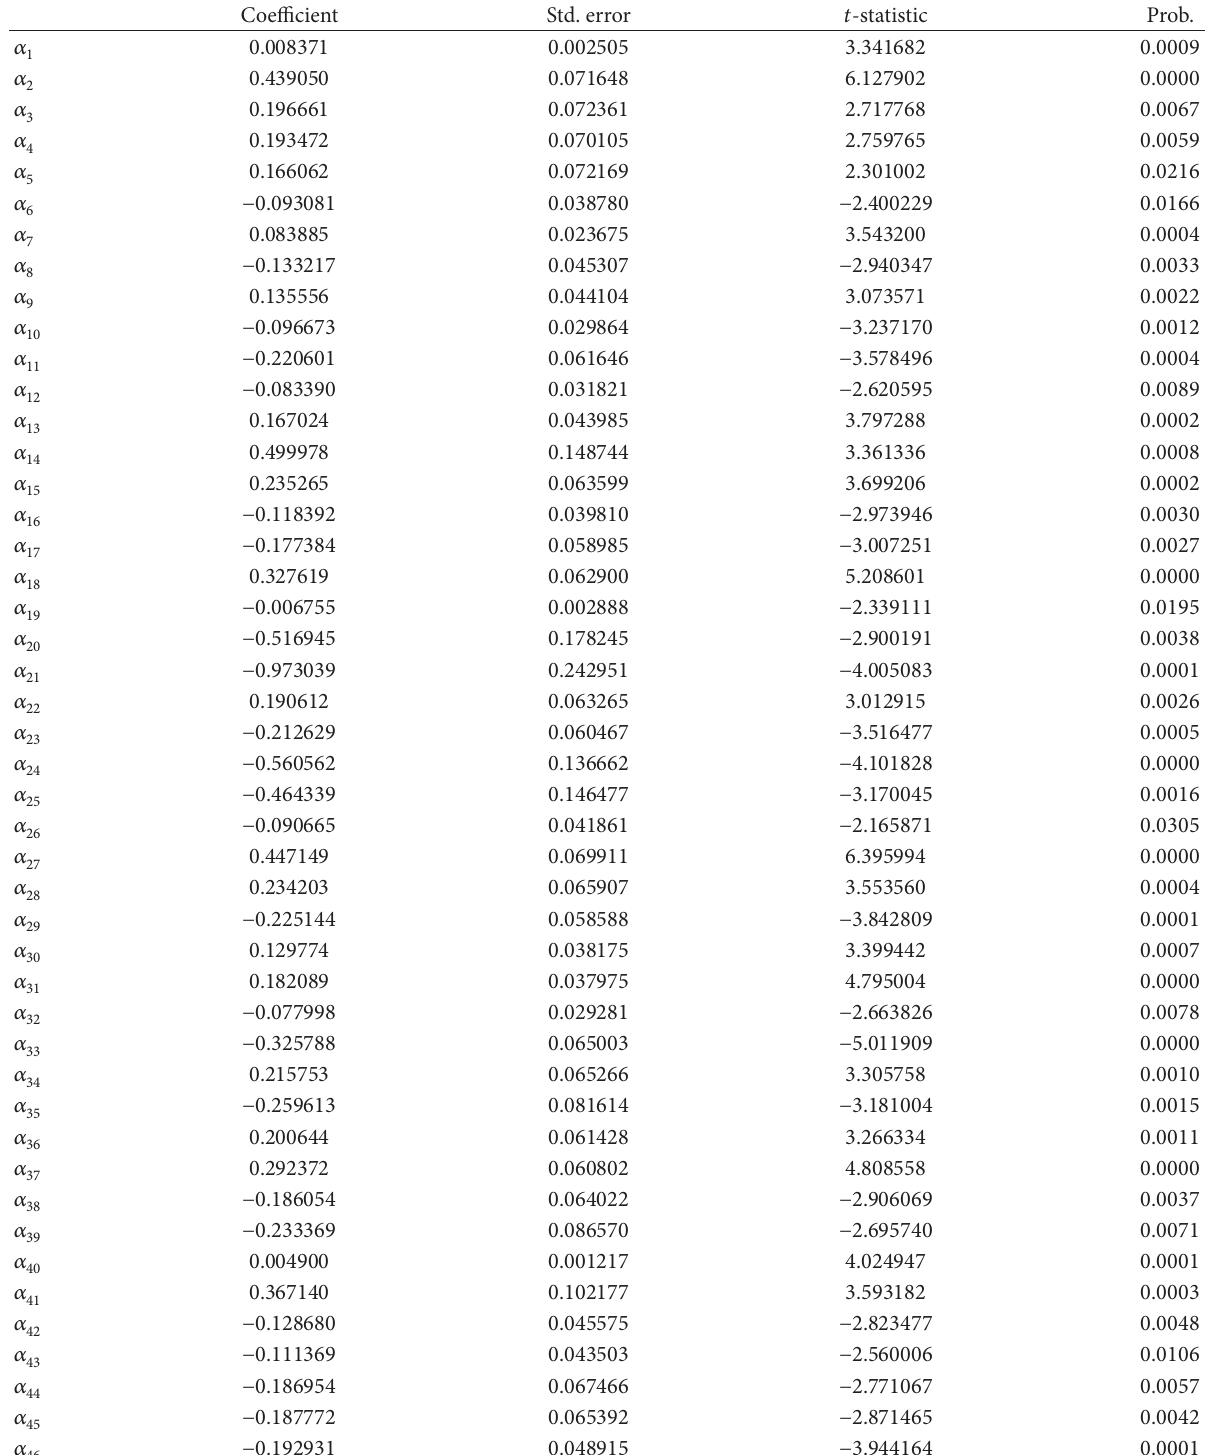
Table 1: Coefficients and their statistical